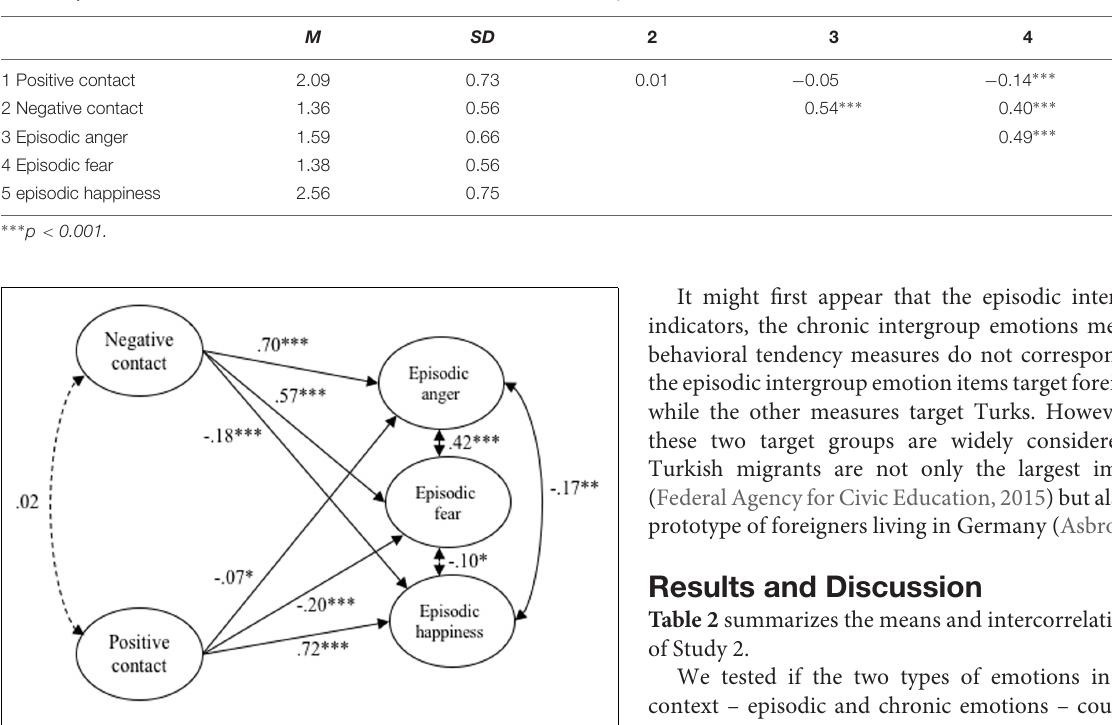
excluded from answering other relevant questions. The